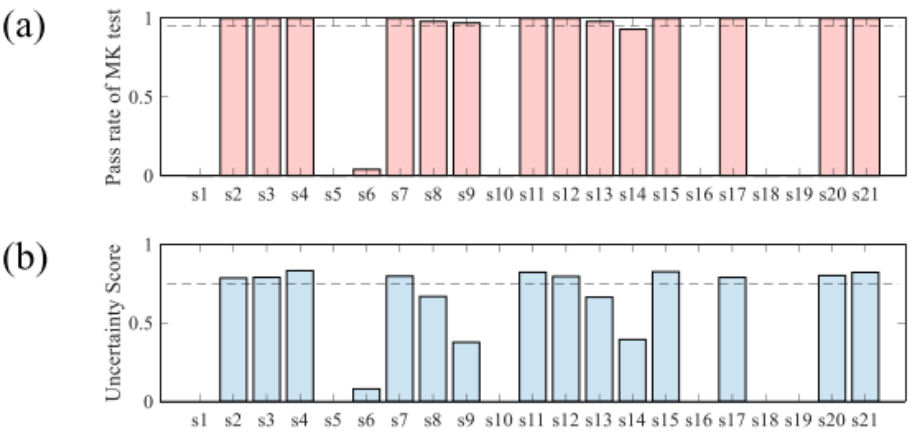
Figure 7. The most relevant features selected based on two different relevance scores by [35]. ( a ): pass rate of MK test; ( b ): Uncertainty Score.